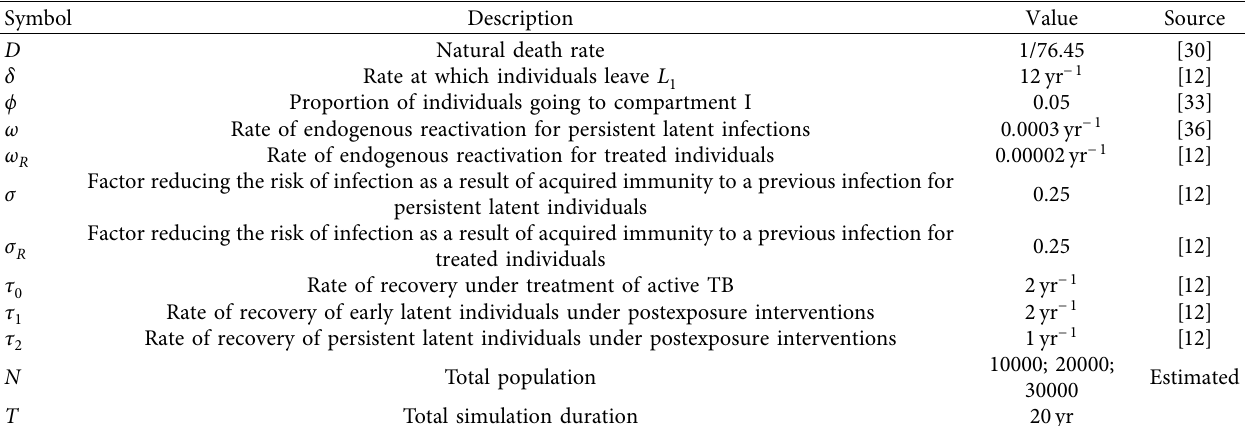
Table 1: Parameter